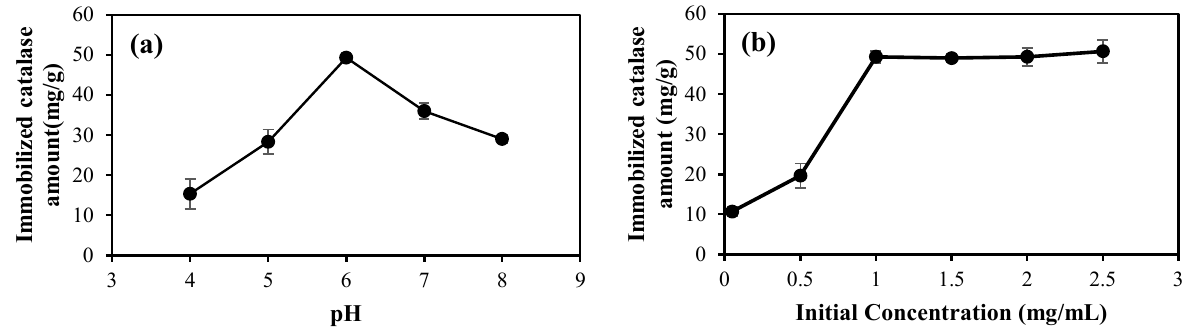
Figure 6. ( a ) Effect of pH on catalase binding amount onto p(HEMA-co-AGE) cryogel [catalase con- centration: 1.0 mg/mL; flow rate: 1.0 mL/min; T: 25 °C], and ( b ) effect of initial catalase concentration on catalase binding amount onto p(HEMA-co-AGE) cryogel [reaction conditions: 50 mM phosphate buffer pH 6.0; flow rate: 1.0 mL/min; T: 25 °C].